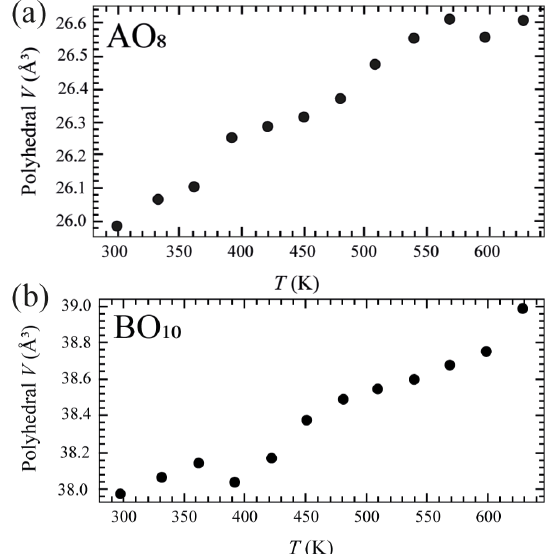
Figure 6. Temperature-induced evolution of AO 8 (a) and BO 10 (b) polyhedra in the crystal structure of burbankite. The fitted ther- mal expansion using a one-term Holland-and-Powell curve results in 14.5(7) × 10 − 5 K and 14.5(6) × 10 − 5 K coefficients, respectively, in the two